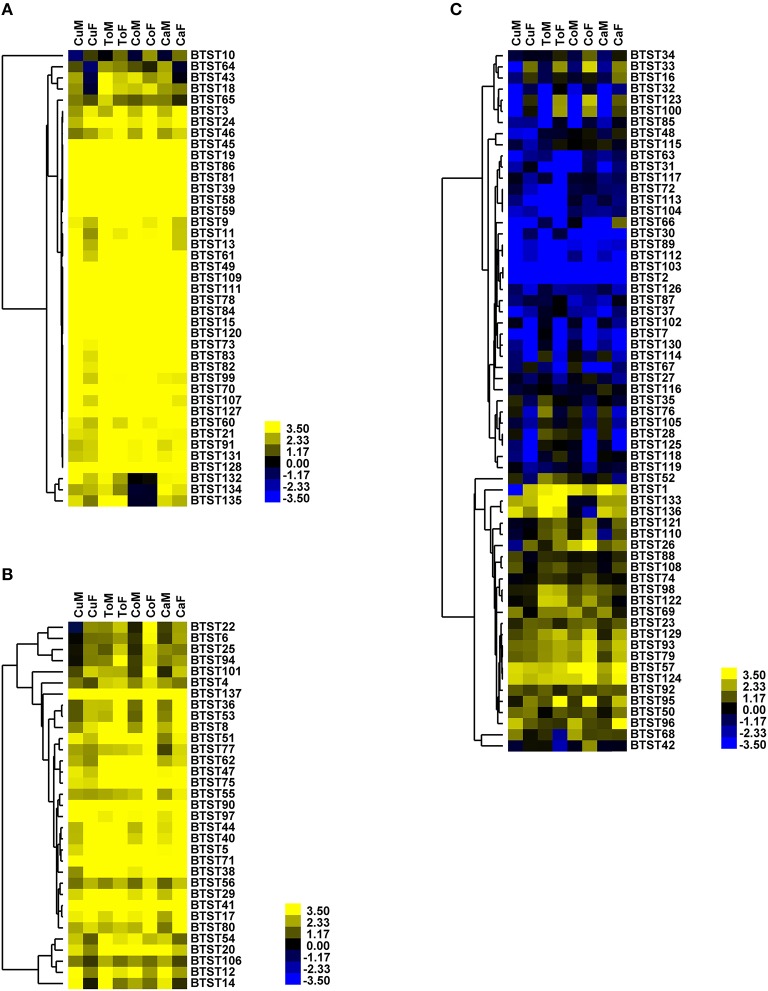
Gene expression of BTSTs in male and female adults that fed on different host plants. CaF, females reared on cabbage; CaM, males reared on cabbage; CuF, females reared on cucumber; CuM, males reared on cucumber; CoF, females reared on cotton; CoM, males reared on cotton. ToF, females reared on tomato; ToM, males reared on tomato. (A) Group 1; (B) Group 2; (C) Group 3.